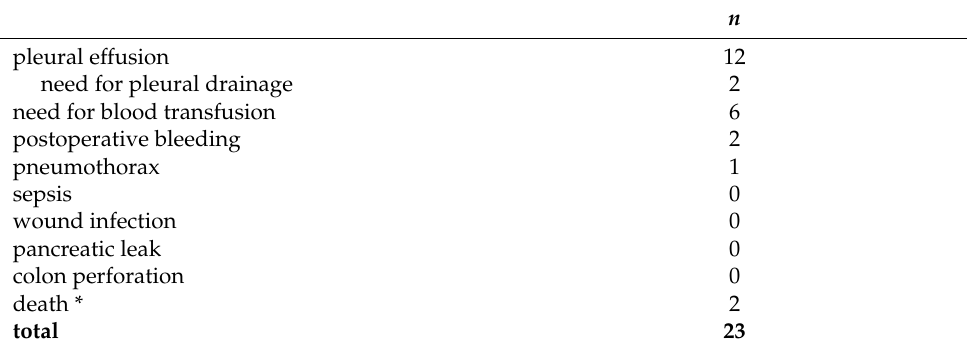
Table 3. Perioperative complications (patients n =